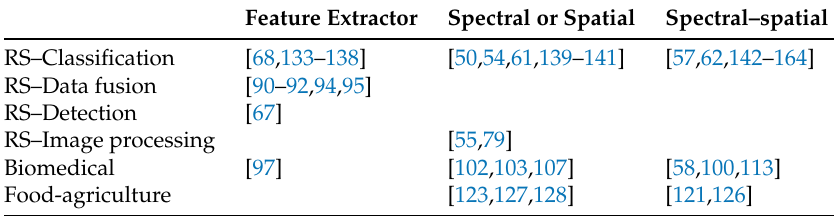
Table 1. HSI-DL studies exploiting CNNs represented by target use (columns) and field—task